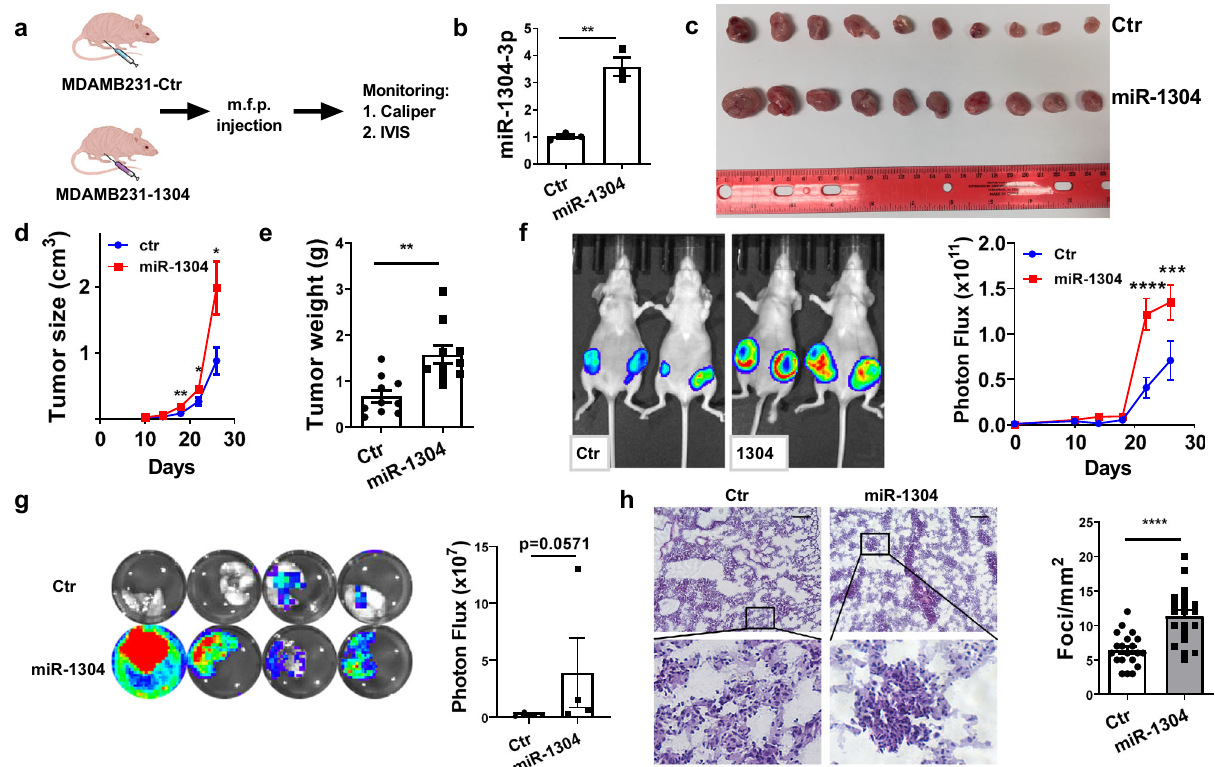
Fig. 2 | miR-1304-3p promotes cancer progression in vivo. a Scheme of experi- mental procedures. MDAMB231 cells stably expressing miR-1304 or control were labeled with luciferase and injected into mammary fat pads of 8-week-old nude mice, and tumor growth was monitored by IVIS bioluminescence imaging and tumor size was measured by caliper, tumor size was calculated by 0.5 * length * width 2 (0.5*LW2). b Quanti fi cation of miR-1304-3p by TaqMan assay in blood samples from the MDAMB231-Ctr and MDAMB231-1304 tumor-bearing mice at the endpoint.Serumsamplesfromthreemiceineachgroupwereusedandanalyzedby the two-tailed unpaired student t-test. p = 0.0018. c The photo image of tumors collected at the endpoint. N = 10 for each group. d Tumor size (0.5*LW2) was quanti fi edbycalipermeasurements(two-wayANOVA,day18: p= 0.008477,day22: p = 0.028171, day 26: p = 0.0286), n = 10 biologically independent animals.